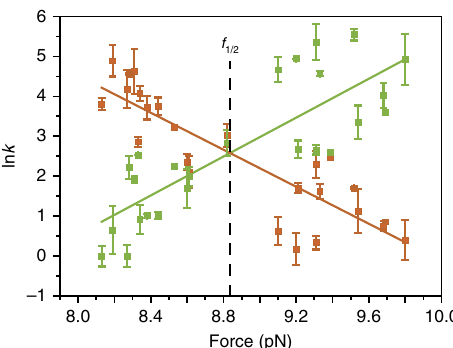
Fig. 4 Dependence of shuttling rates with force. The shuttling rates from fum to succ station, k k fum (green), and the backward rates, succ (orange), vary exponentially with force. The values of lnk are represented as mean ± standard deviation. Fits of the data with the Bell-Evans theory revealed the coexistence force, f 1/2 , and the main parameters of the